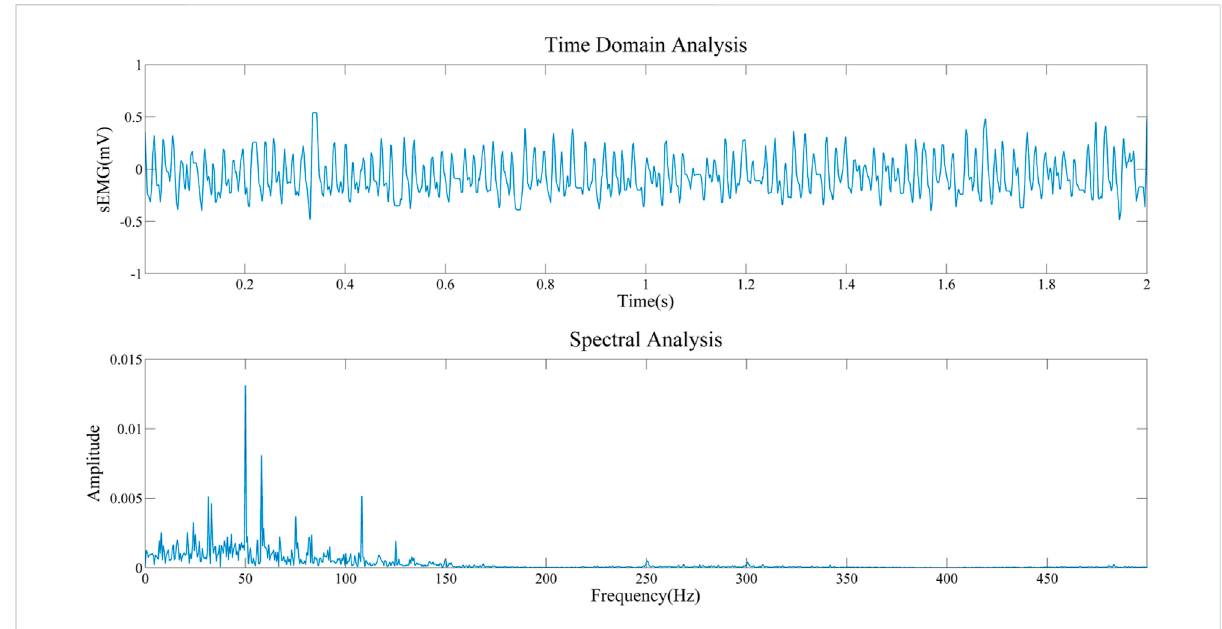
FIGURE 12 Frequency domain analysis in the relaxed